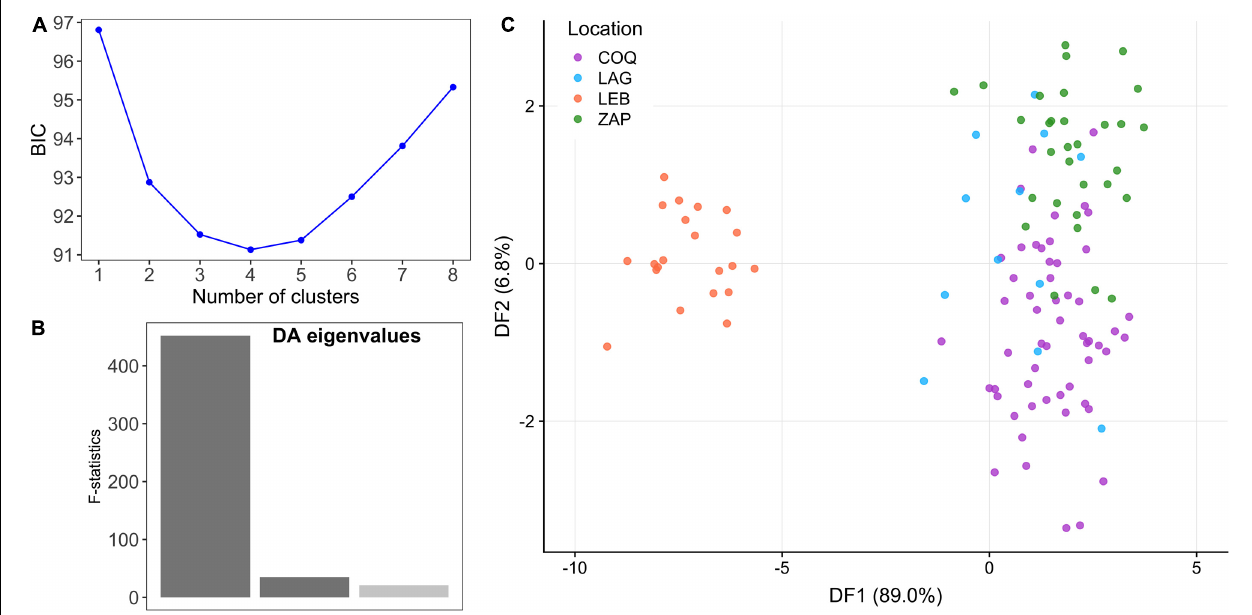
FIGURE 3 | Discriminant analysis of principal components. (A) Bayesian Information criterion (BIC) values for increasing values of K , indicate that the number of clusters in the date set is between 2 and 4. (B) Discriminant analysis eigenvalues of the three retained discriminant functions. (C) Clusters obtained by discriminant analysis of principal components. Clusters are shown by different colors; each point represents an individual.